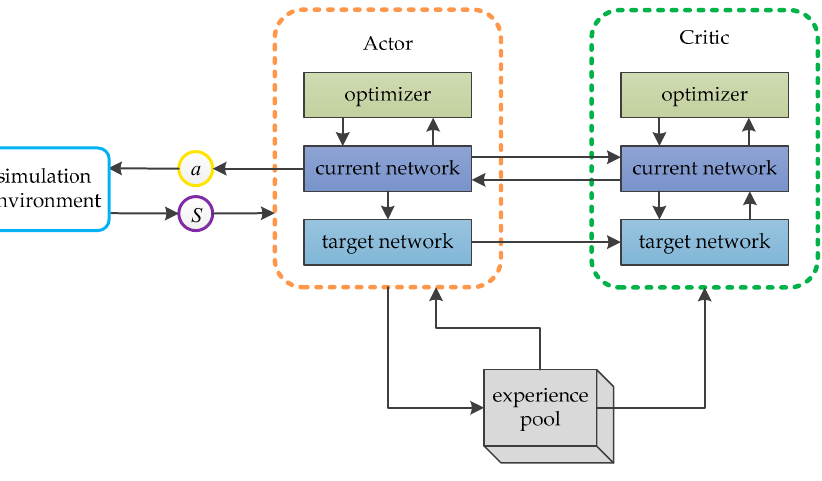
Figure 1. The structure of DDPG algorithm.